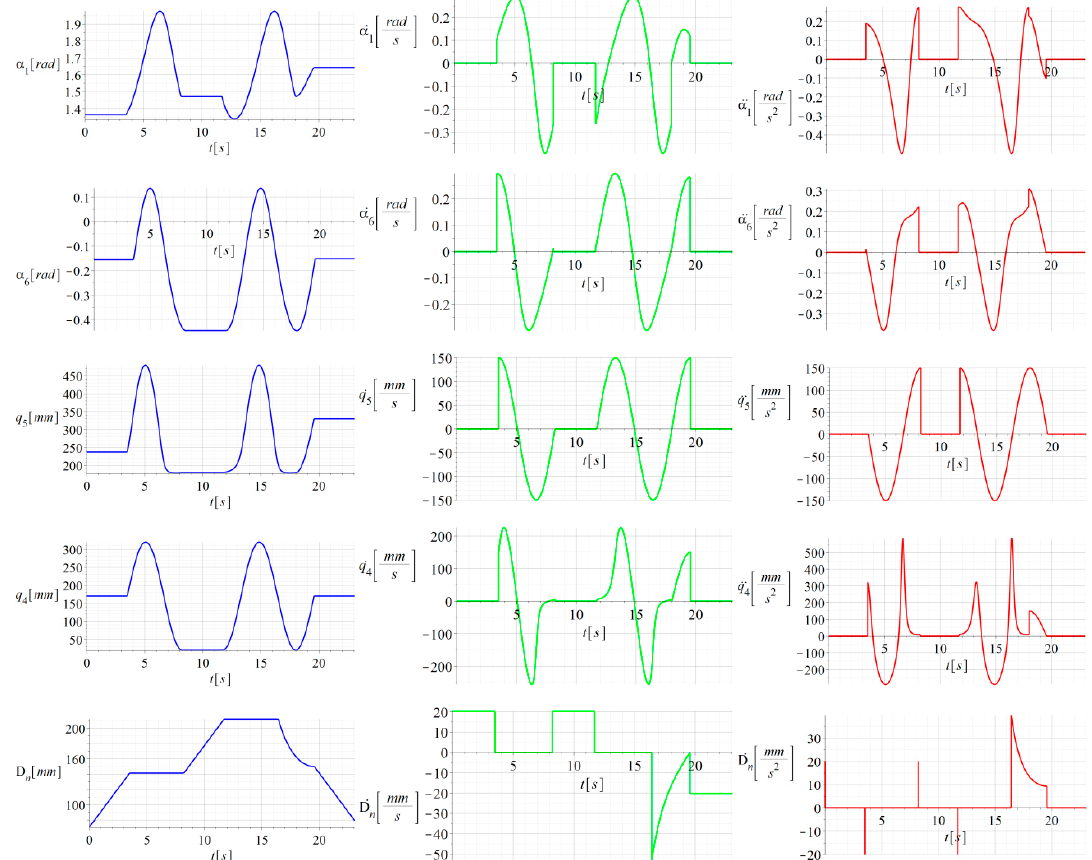
Figure 6. Numerical simulation representing the PRO-HEP-LCT actuators (moving with respect to a prescribed trajectory of the end effector).